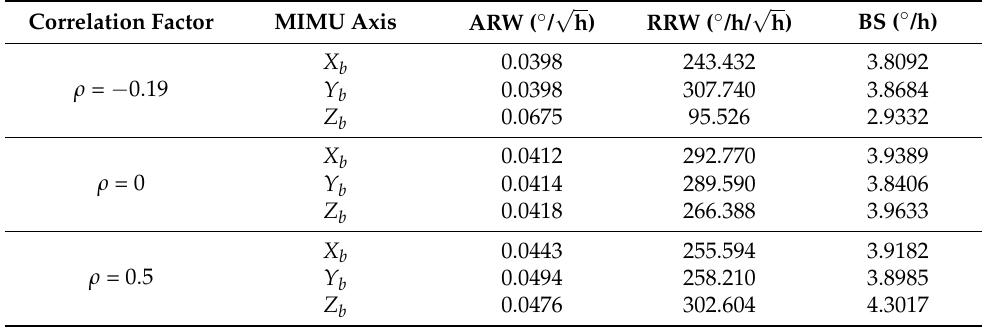
Table 4. Results of Allan variance of 6-gyro MIMU for scheme 2.